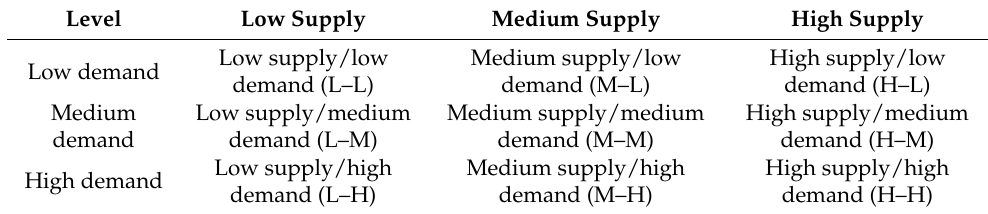
Table 2. Classification of supply and demand relations